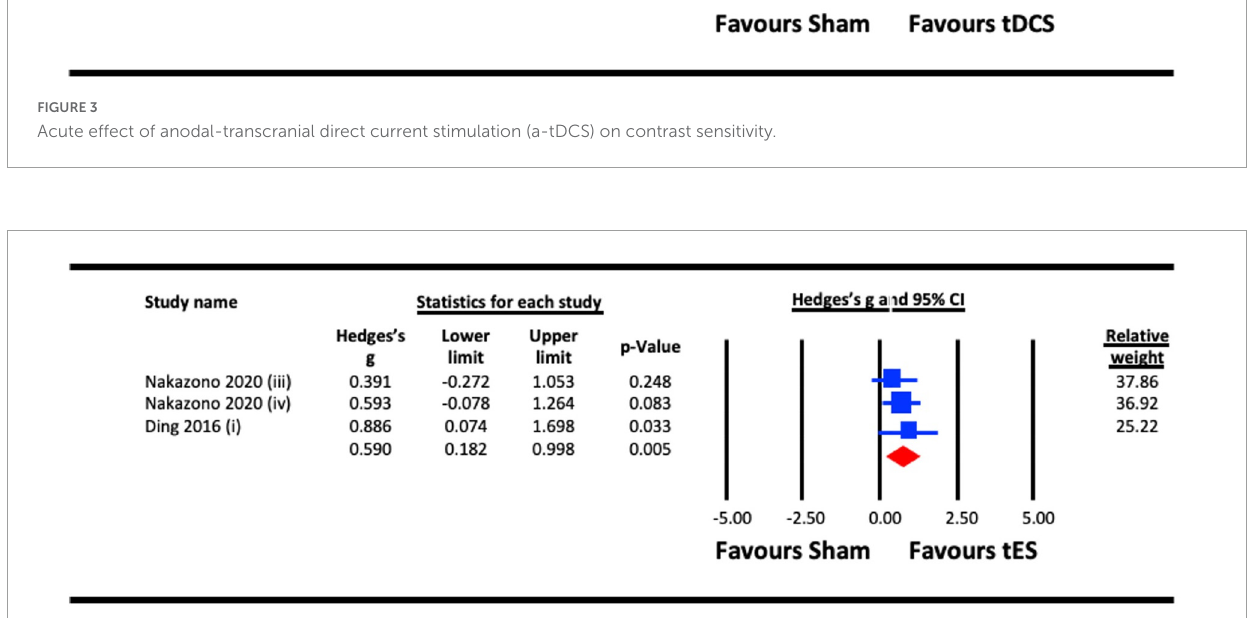
FIGURE4 Aftereffect of transcranial electrical stimulation (tES) [anodal-transcranial direct current stimulation (a-tDCS) and transcranial alternating current stimulation (tACS)] on contrast sensitivity. Meta-analyses for Nakazono (2020) were separated for data on 9.0 cpd beta (at 10 min post) and 9.0 cpd alpha (at 10 min post), represented as Nakazono (2020) (iii) and Nakazono (2020)